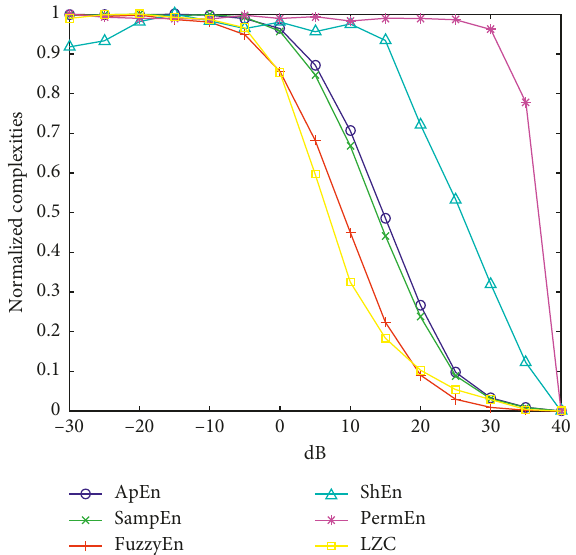
Figure 17: The curve of six complexities versus SNRs.